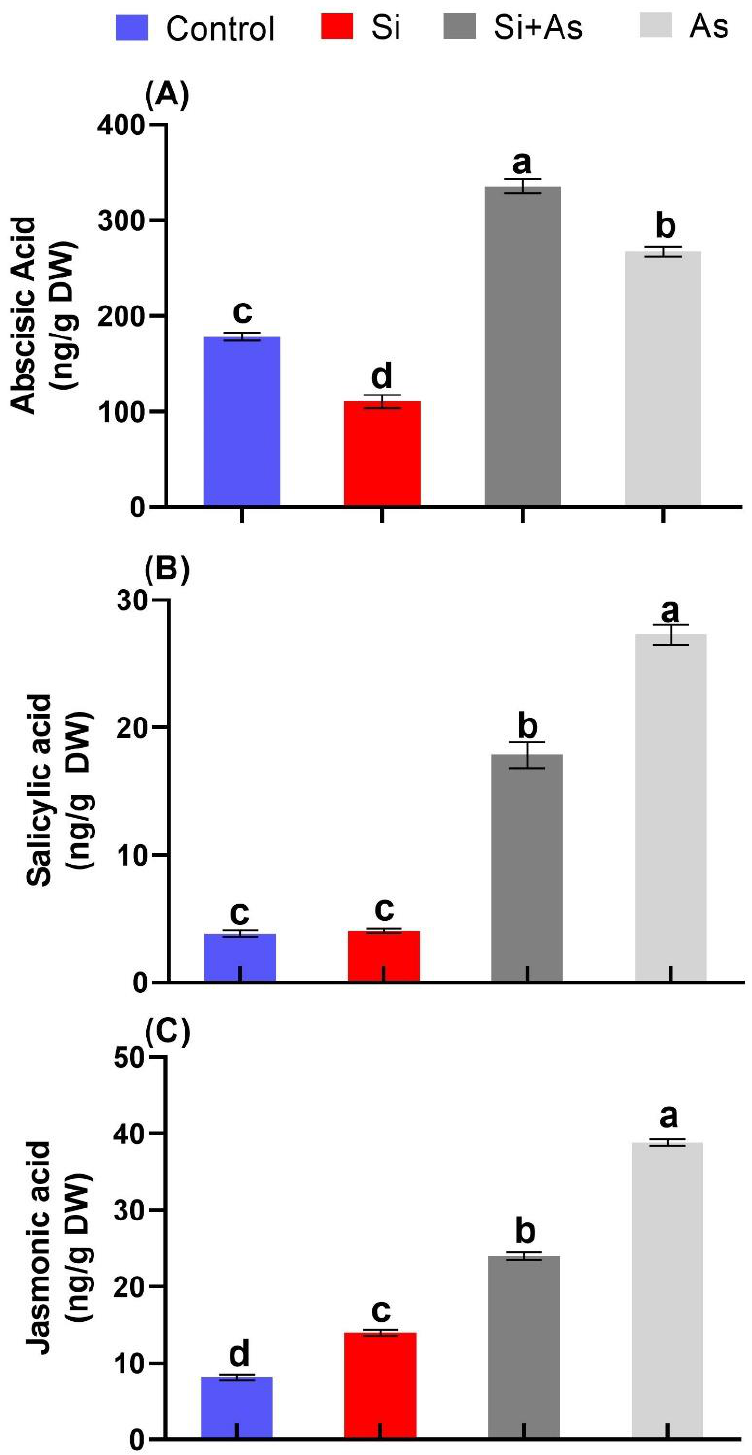
Figure 6. Effects of arsenic stress and silicon treatments on regulation of endogenous hormone, i.e., ( A ) abscisic acid, ( B ) salicylic acid, ( C ) jasmonic acid in date palm seedlings, treated with silicon and arsenic. Data represented as mean (4 replicas) ± shows standard error, symbols denote significant differences among values as determined by Duncan’s multiple range test (DMRT).